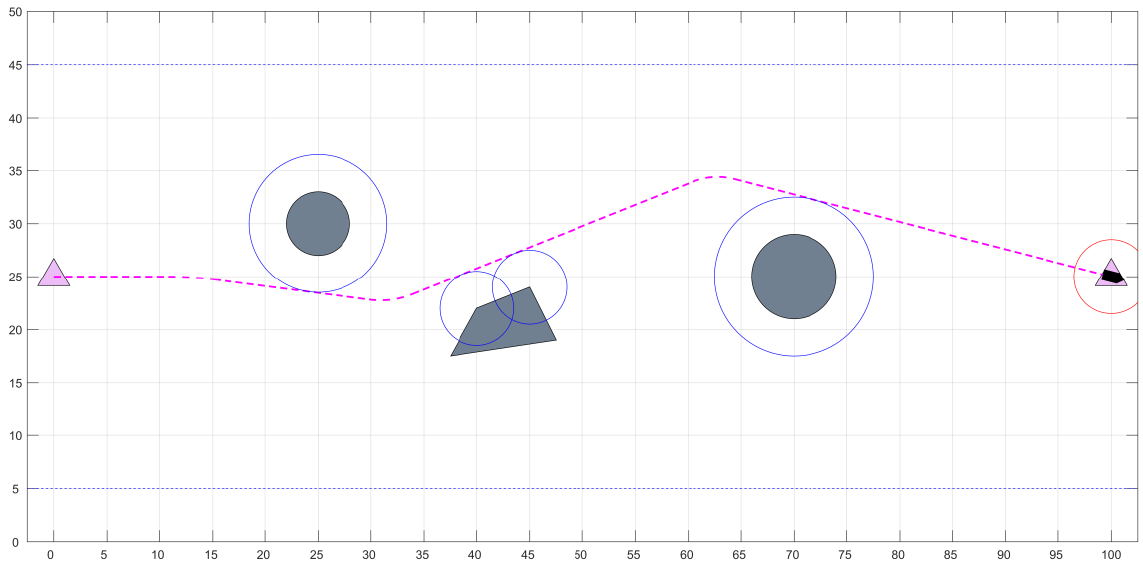
Figure 14. Simulation result of static-obstacle avoidance.